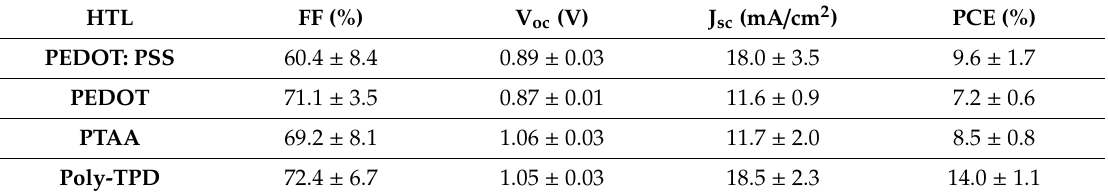
Table 1. The average measured photovoltaic parameters for inverted planar perovskite solar cell with di ff erent polymeric hole transporting layers (HTLs) under AM1.5G illumination (~100 mW / cm − 2